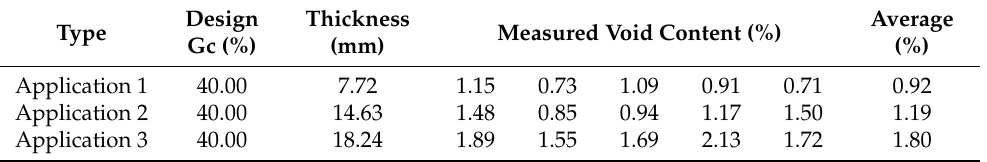
Table 4. Measured void content of the fabricated hull plate